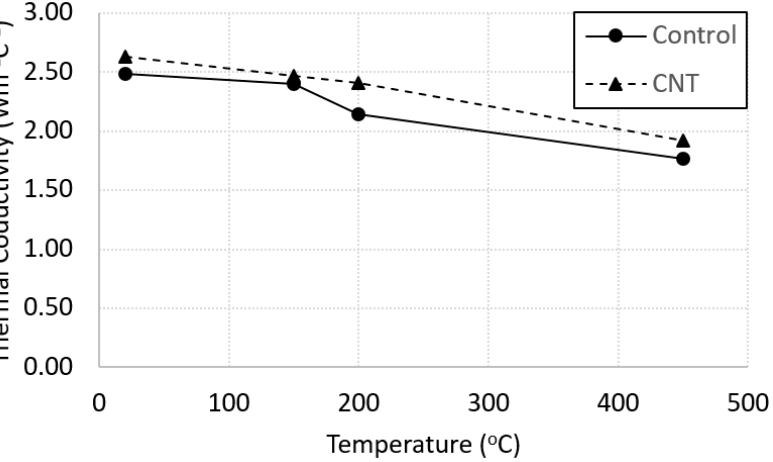
Figure 6. Thermal conductivity of plain and CNT-reinforced specimens as a function of elevated temperatures.